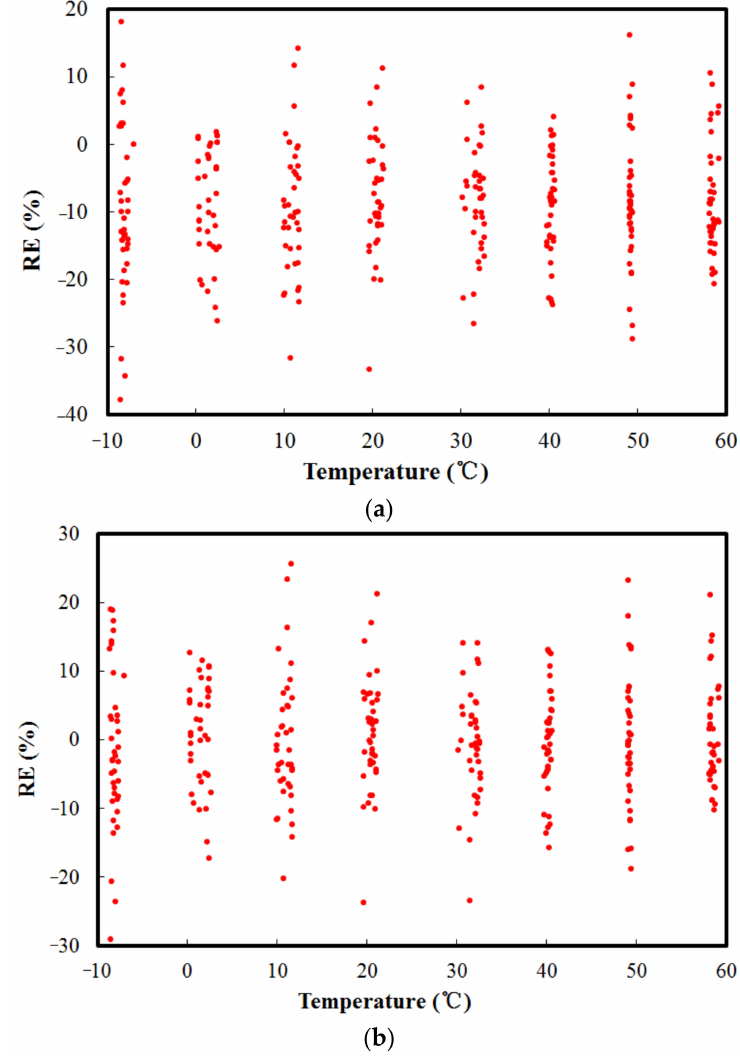
Figure 5. Compensation results obtained using polynomial fitting method: ( a ) RE of applied force and predicted force using linear fitting method; ( b ) RE of applied force and predicted force using quadratic fitting